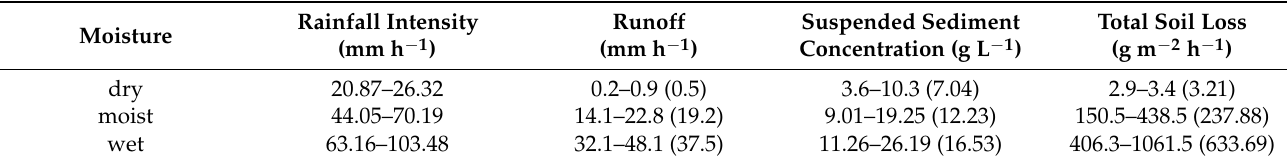
Table 4. Erosion resulting from individual rainfall simulations (mean values in brackets).